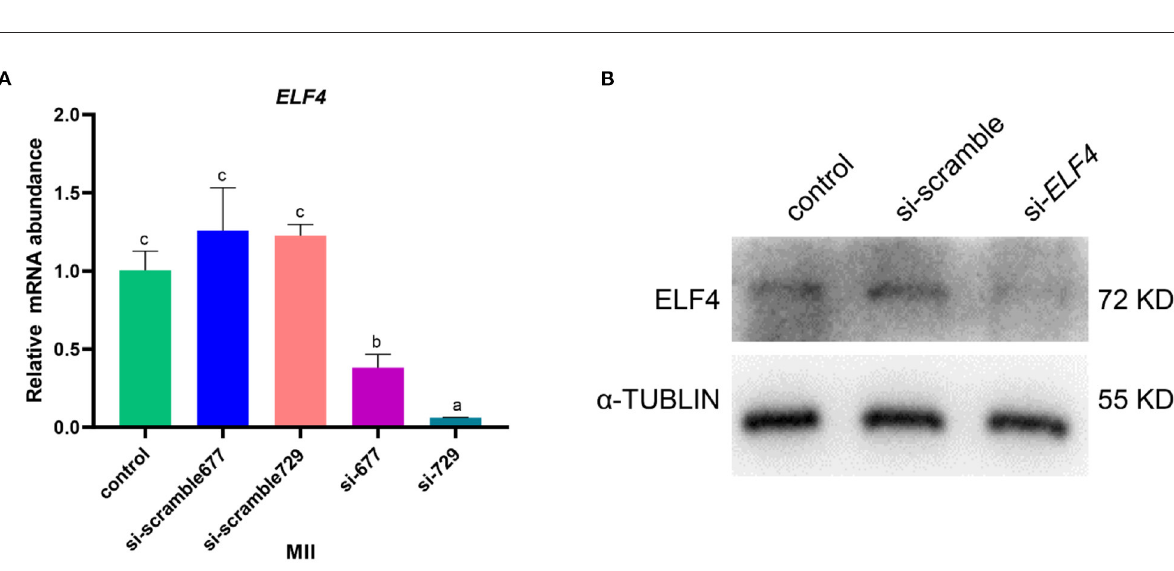
FIGURE2 Screening of interfering RNAs of ELF4. (A,B) Interference efficiency of ELF4 siRNA at the transcriptional (A) and protein levels (B) . Different lowercase letters indicate statistical differences ( p <